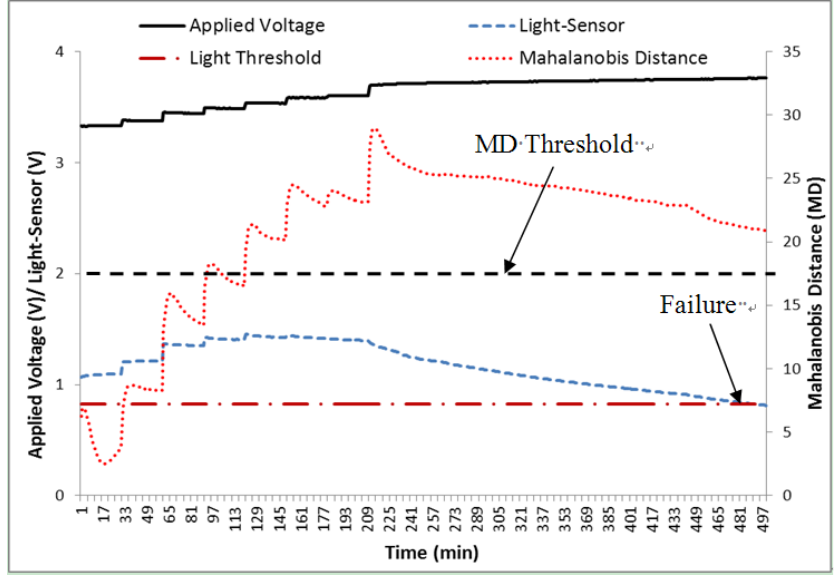
Figure 15. Demonstration of Mahalanobis